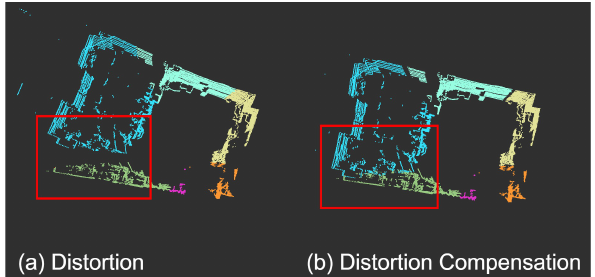
Figure 3. Calibrated results: ( a ) the point cloud suffered from distortion when LiDAR is moving, and ( b ) the result obtained after distortion compensation. Different colors indicate subframes in one sweep.